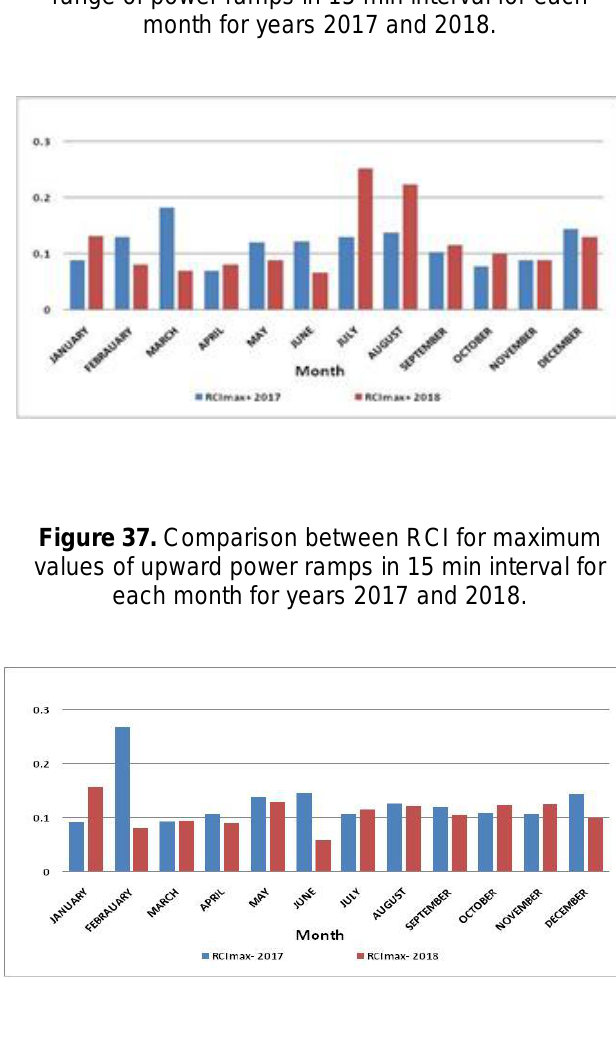
Figure 38. Comparison between RCI for maximum values of downward power ramps in 15 min interval for each month for years 2017 and 2018